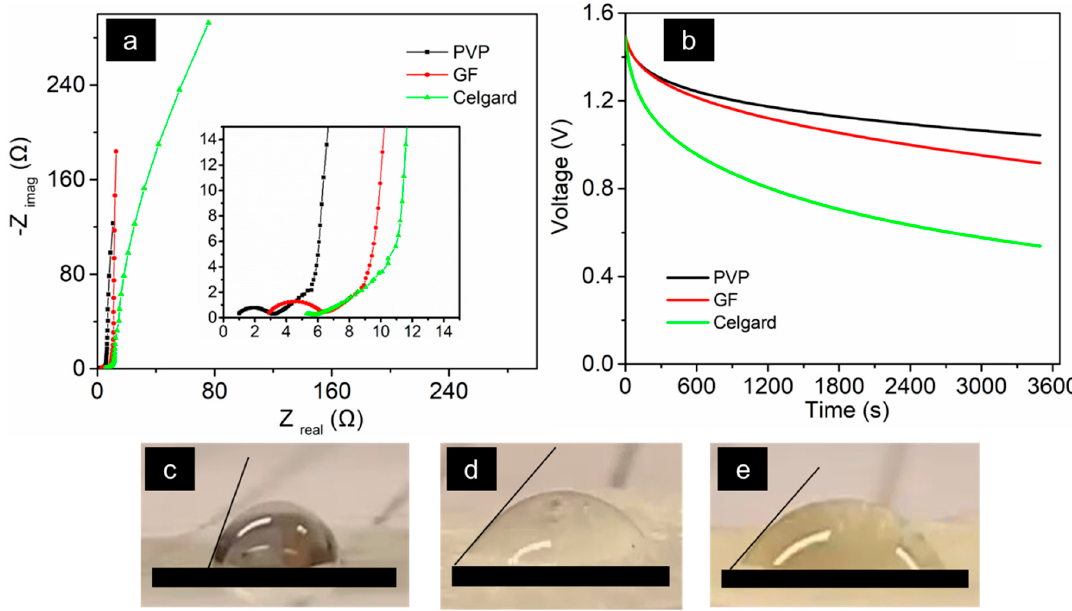
Figure 8. ( a ) Nyquist plot of the MSCs (same devices as in Figure 7). ( b ) Open circuit voltage (OCV) decay over time. The measurements used an AC electrode, 1-ethyl-3-methylimidazolium acetate (EmImAc) ionic liquid electrolyte, and three different separators. ( c – e ) The optical images used for the preliminary contact angle measurements of PVP, Glass fiber, and the Celgard separators, respectively.